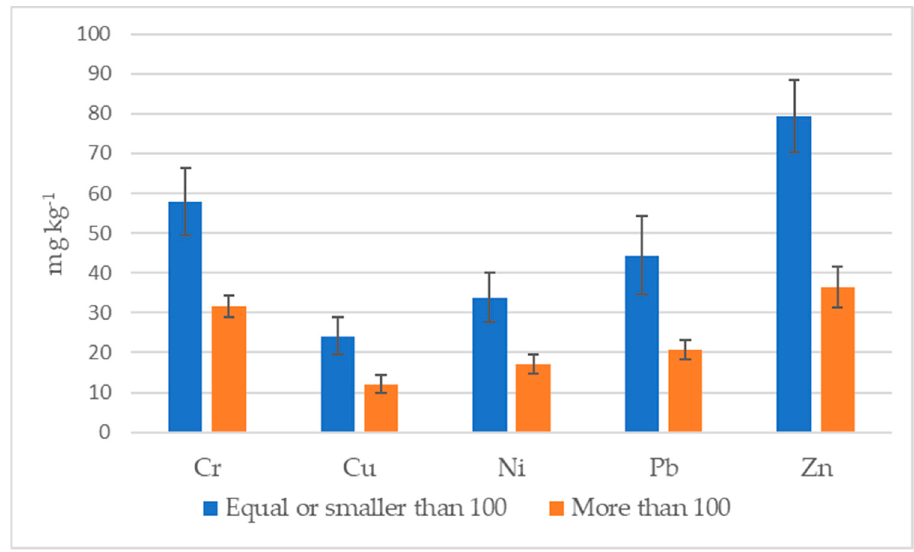
Figure 6. Comparison of mean element concentration against distance—for metals from the sides with the upwind direction.